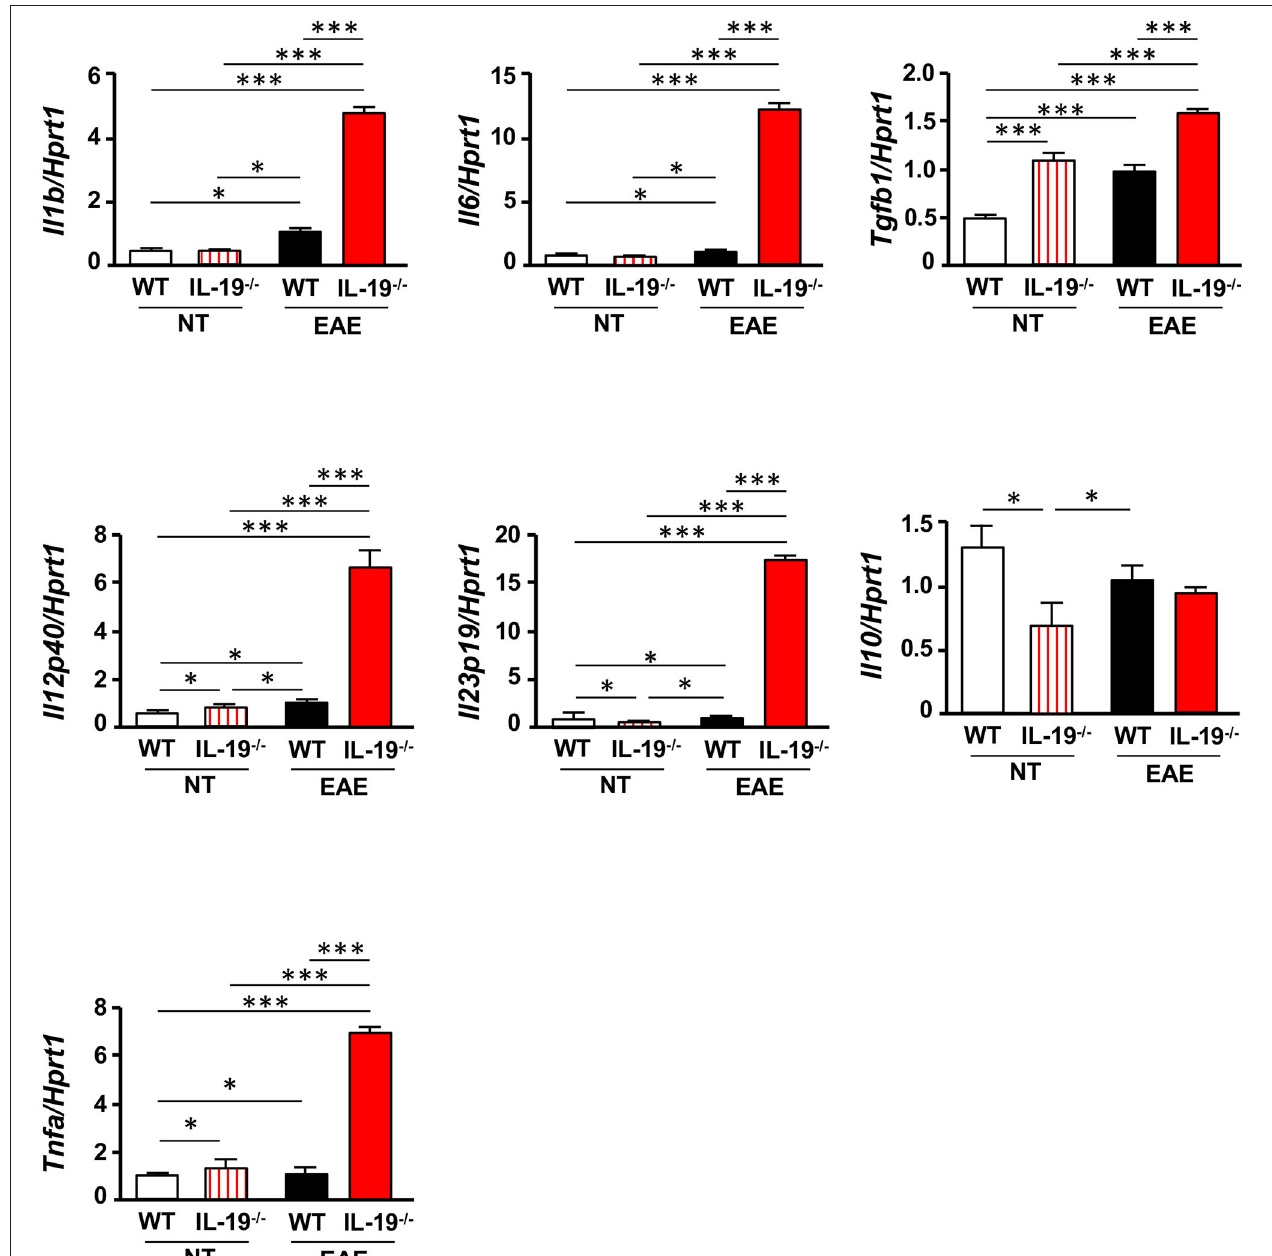
FIGURE 4 | IL-19 deficiency upregulates Th17 cell differentiation–associated cytokines in macrophages. qPCR data for mRNAs encoding IL-1 β , IL-6, TGF- β 1, IL-12 p40, IL-23 p19, IL-10, and TNF- α in splenic macrophages of untreated (non-immunized) mice or EAE mice. Assessments of the samples from EAE mice were performed 7 days after immunization. Statistical significance was analyzed using one-way ANOVA followed by post-hoc Tukey’s test. Data represent means ± SEM. * p < 0.05; *** p < 0.0001 ( n = 6). NT, untreated mice.